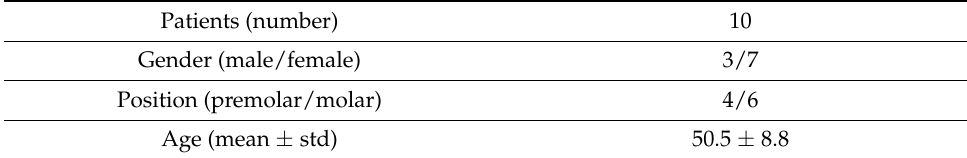
Table 1. Anamnestic data of the sample, std: standard deviation.